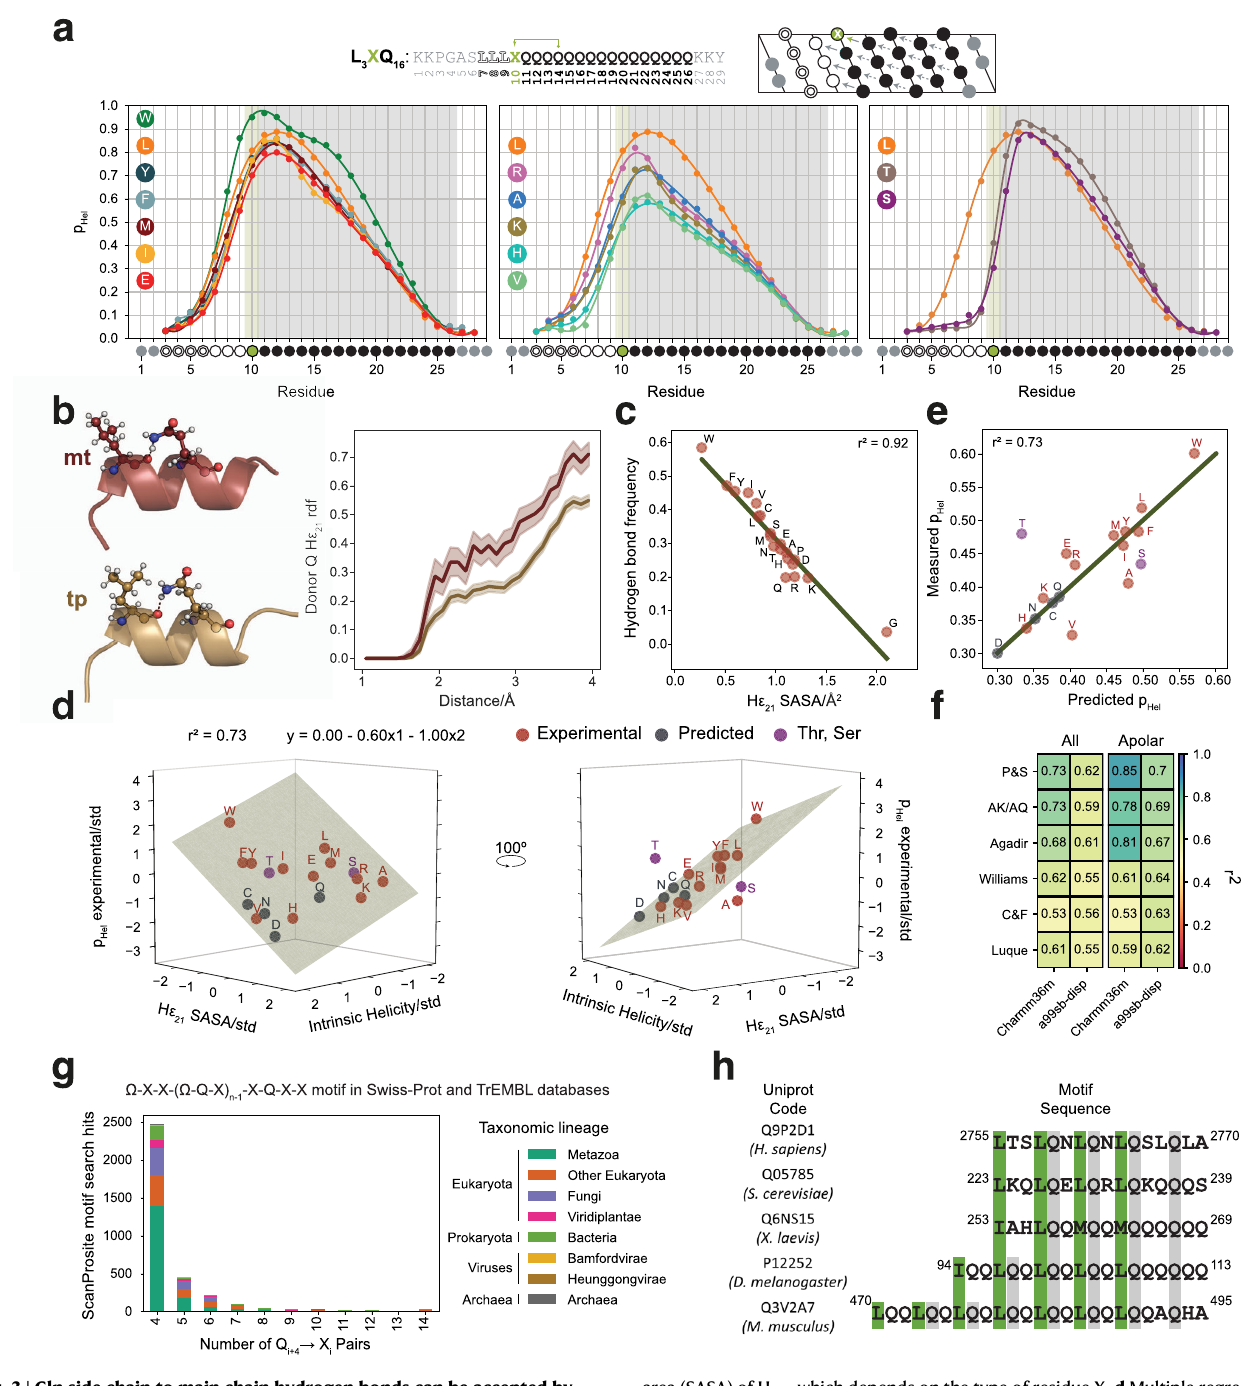
area (SASA) of H ε 21 , which depends on the type of residue X. d Multiple regression correlating intrinsic helicity (x1) (Pace and Scholtz scale 29 ) and SASA (x2) with the average helicity (y): the data were standardized to estimate the relative weight of each variable in de fi ning the model. e Measured versus predicted average L 3 XQ 16 helicity. f Squared r correlation scores ( r 2 ) for the multiple regression shown in e , using different reported scales for intrinsic amino acid helicity and H ε 21 SASA valuesderived from twosets of 1 μ s MD trajectoriesindependentlygeneratedwith different force fi elds. The results are shown for all and apolar (L, I, V, F, Y,M, W, A) residues in position X. g Number of ScanProsite-identi fi ed protein sequences in UniprotKB(including the Swiss-Prot and TrEMBLdatabases) containing the (P3-7) n motif with an increasing number of Gln i+4 → Ω i pairs ( Ω =W, L, Y, F, I, M; X=any amino acid). h Representative (P3-7) n -like natural sequences with UniprotKB annotation score=5.